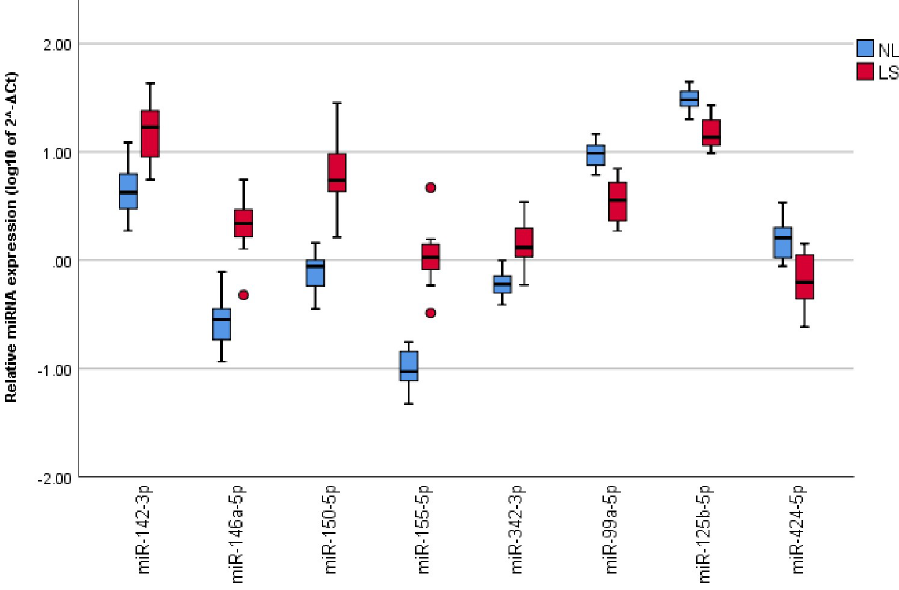
Fig 3. The top eight differentially expressed miRNAs. The top eight differentially expressed miRNAs between the LS and non-LS cohorts from the screening analysis. FDR < 0.001 and a FC of < -2 or > 2.